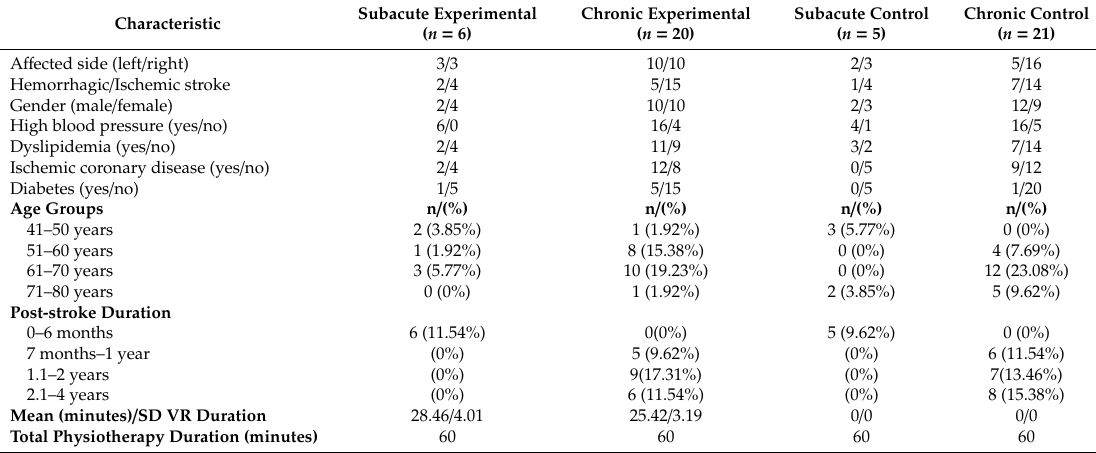
Table 1. Patients’ characteristics.